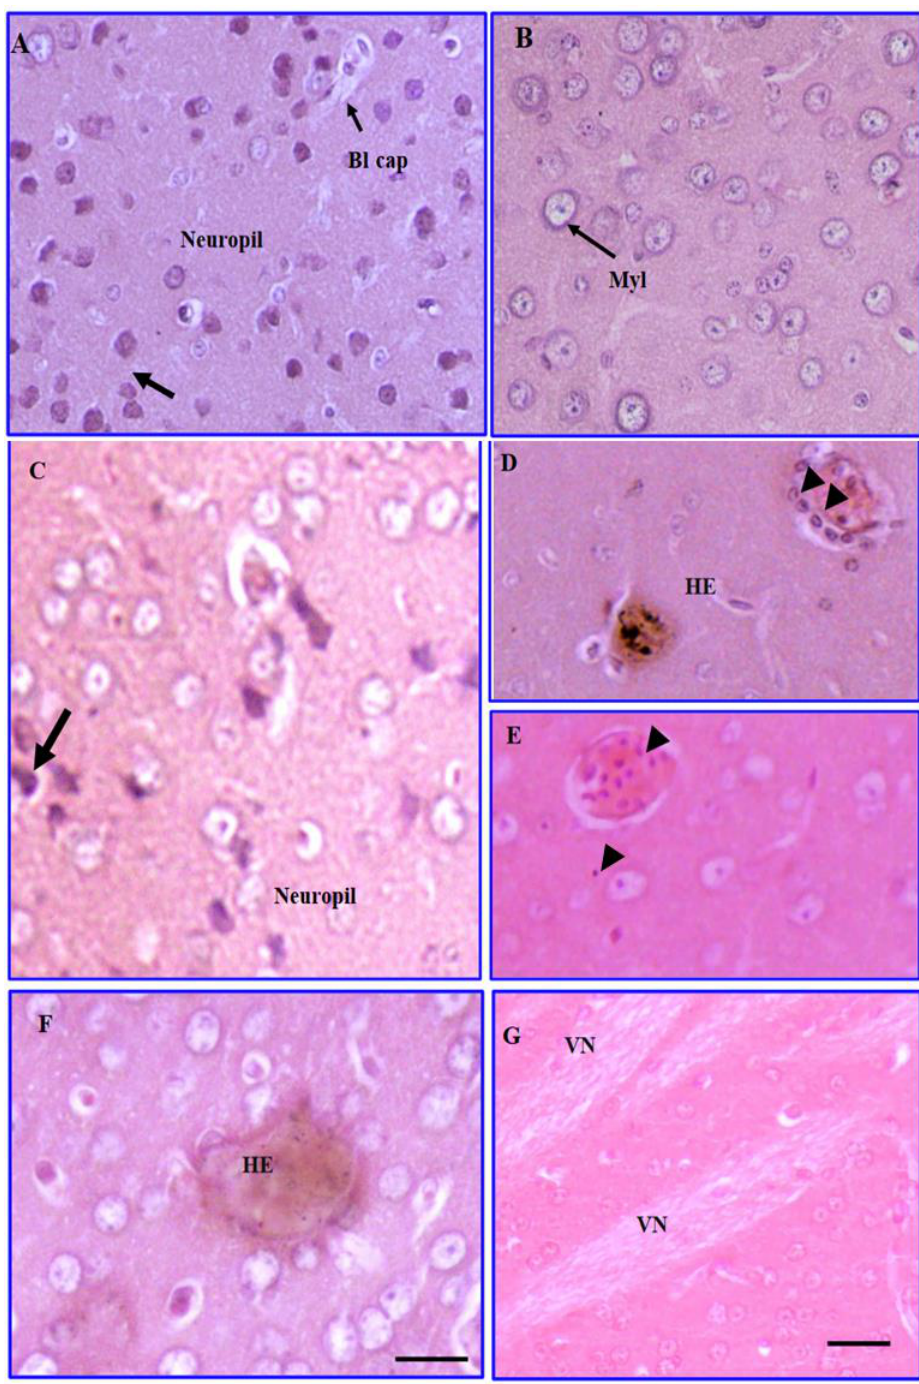
Figure 3. Histopathological alterations in cerebral hemispheres of brain of control ( A , B ) and diabetic mothers ( C – G ). Vacuolated neuropil (VN), abnormal appearance or hemorrhage (HE), infiltration of inflammatory cells (arrowheads), blood capillary (B cap), myelinated nerve cells (Myl). n = 4 – 5, magnification bar equals 10 um.